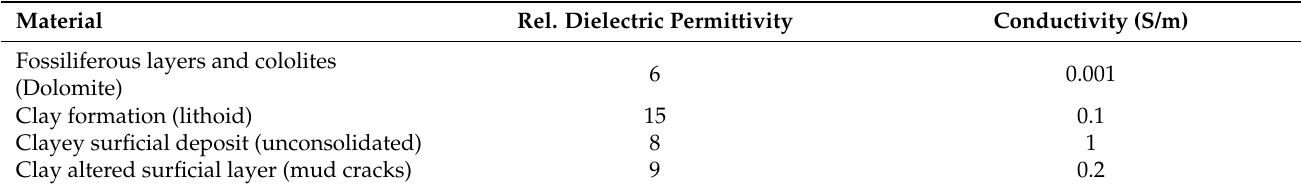
Table 4. Electromagnetic properties set up for media of model